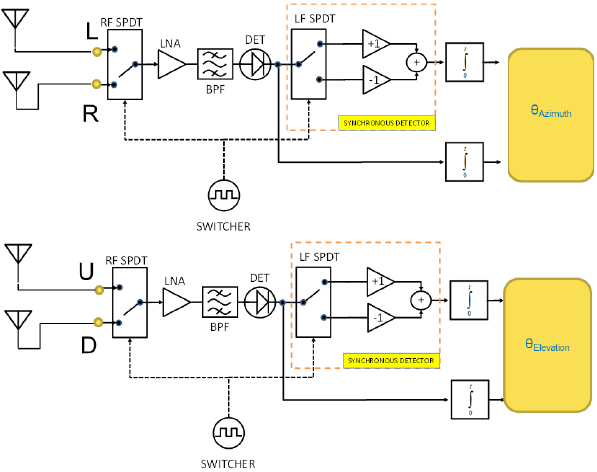
Figure 3. Simplified system-level schematic of a fast sequential-lobing radiometric seeker